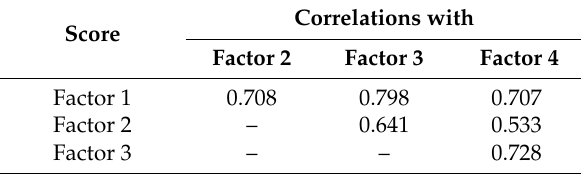
Table 2. Pearson’s correlations between each pair of factors. All six p < 0.0001 ( N = 503). Correlations with Score Factor 2 Factor 3 Factor 4 Factor 1 0.708 Factor 2 – –